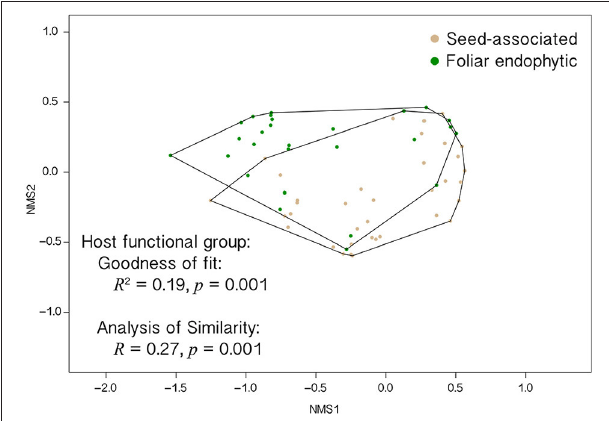
FIGURE 6 | EHB communities differ as a function of the habit of their host fungi (seed-associated vs. foliar endophytic). Non-metric multidimensional scaling (NMS) plot shows fungi that screened positive for EHB separated by differences in their EHB community composition. Relative abundances of non-singleton EHB OTUs were used to calculate Bray-Curtis dissimilarity values among all fungi. This best solution among 999 runs has two dimensions and a stress = 0.11. Independent analyses (goodness of fit test and analysis of similarity) show that host fungal habit (seed-associated vs. foliar endophytic) is associated with significant differences in EHB community composition.